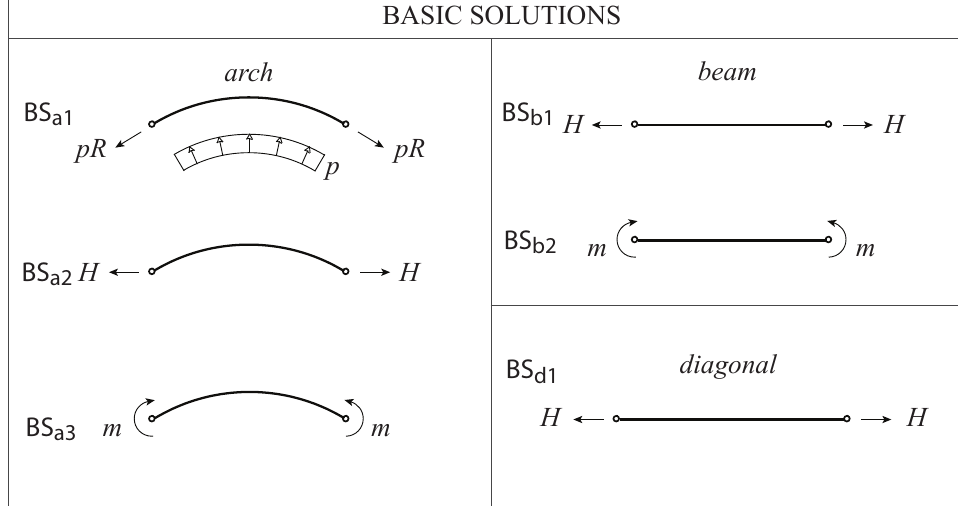
Figure 6. The basic solutions used in the Force Method.